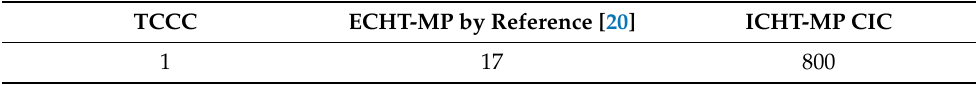
Table 2. CPU-time reduction factor.